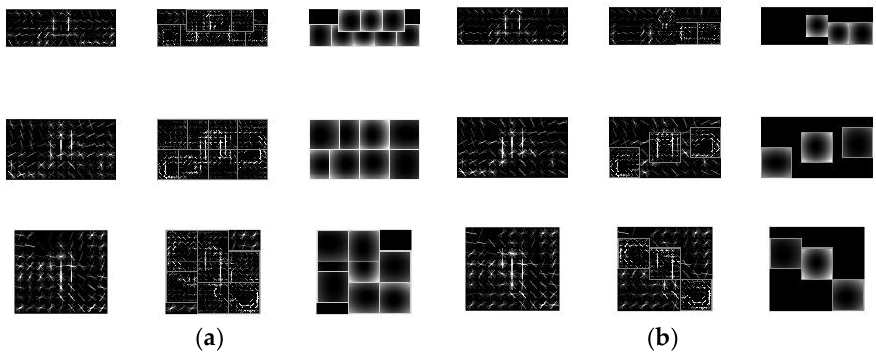
Figure 9. Histogram of oriented gradient (HOG) features trained by DPM. ( a ) Eight sub-models; ( b ) Three sub-models;